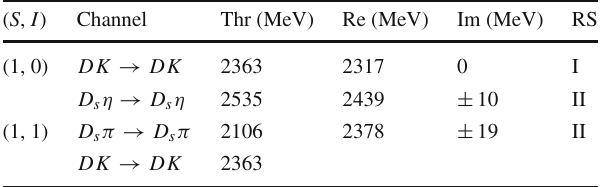
Table 5 Poles in the coupled-channel amplitudes based on UChPT- 6(b) in Table 4 of Ref. [32]. Physical masses and decay constants are used to obtain the poles. The Riemann sheets on which the poles are located are indicated in the last